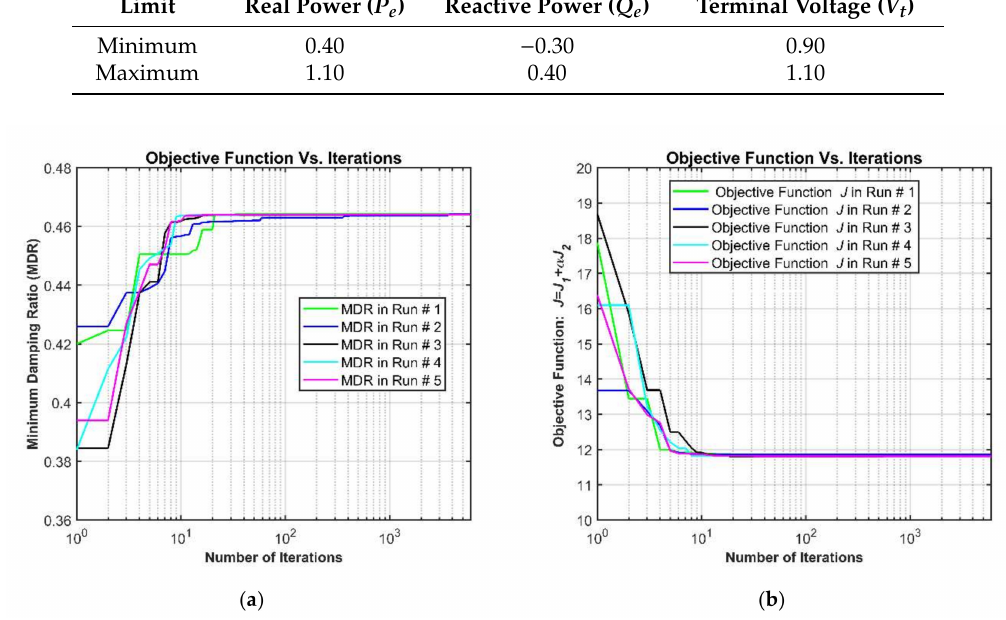
Figure 5. Convergence curves of objective functions for the selected test networks for five di ff erent runs using PSO; ( a ) An arbitrarily generated operating situation of the first test network ( P e = 1.0951 pu, Q e = − 0.0279 pu, and V t = 1.0299 pu) and ( b ) An arbitrarily generated operating situation of the second test network ( P e = 0.6245 pu, Q e = − 0.2626 pu, and V t = 1.0604